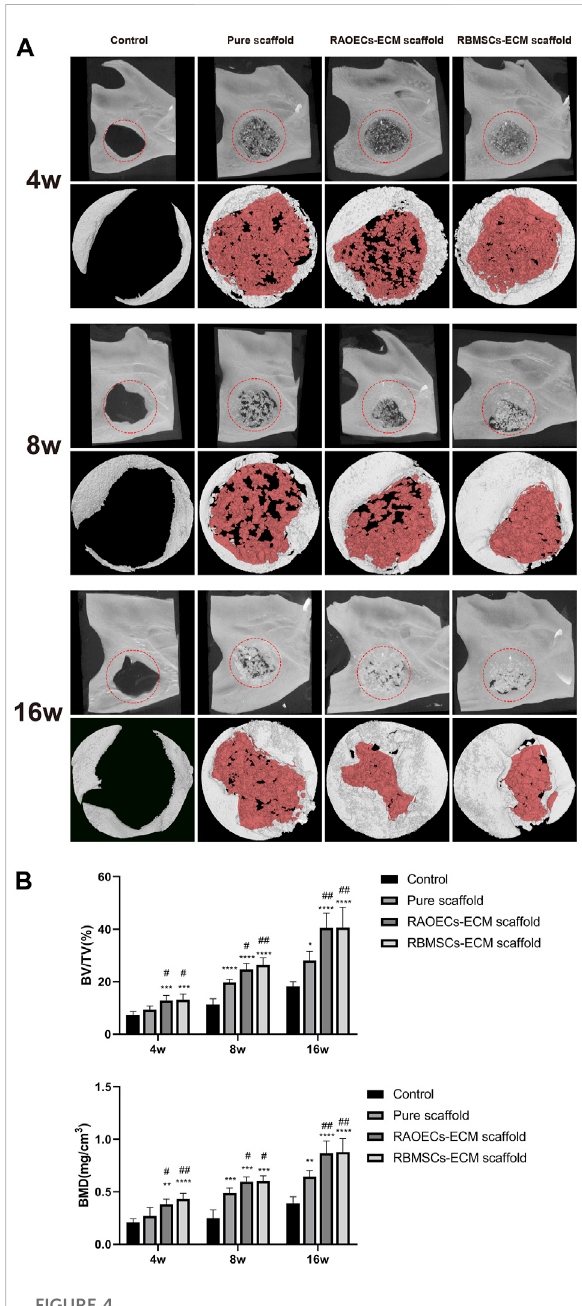
FIGURE 4 Micro – CT analysis of the control, pure scaffold, RAOECs – ECM scaffold and RBMSCs – ECM scaffold groups at 4, 8 and 16 weeks. (A) Three – dimensional images (top) and reconstruction images (bottom) are shown; white indicates new bone, and red represents residual scaffold materials. (B) Bone regenerationanalysisoftheratioofthebonevolume/tissuevolume (BV/TV%) and bone mineral density (BMD, mg/cm 3 ). (Signi fi cant effect compared to the control group: p p < 0.05, pp p < 0.01, ppp p < 0.001, pppp p < 0.0001. Signi fi cant effect compared to pure scaffold: # p < 0.05, ## p < 0.01, n =